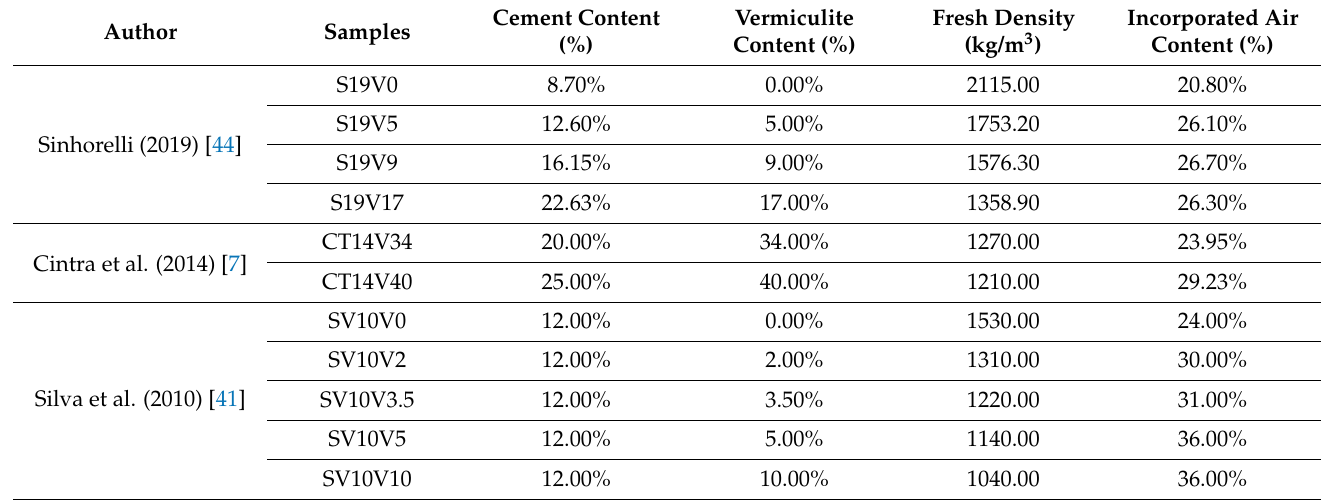
Table 7. Fresh density, incorporated air content, cement, and vermiculite content from different authors’ studies